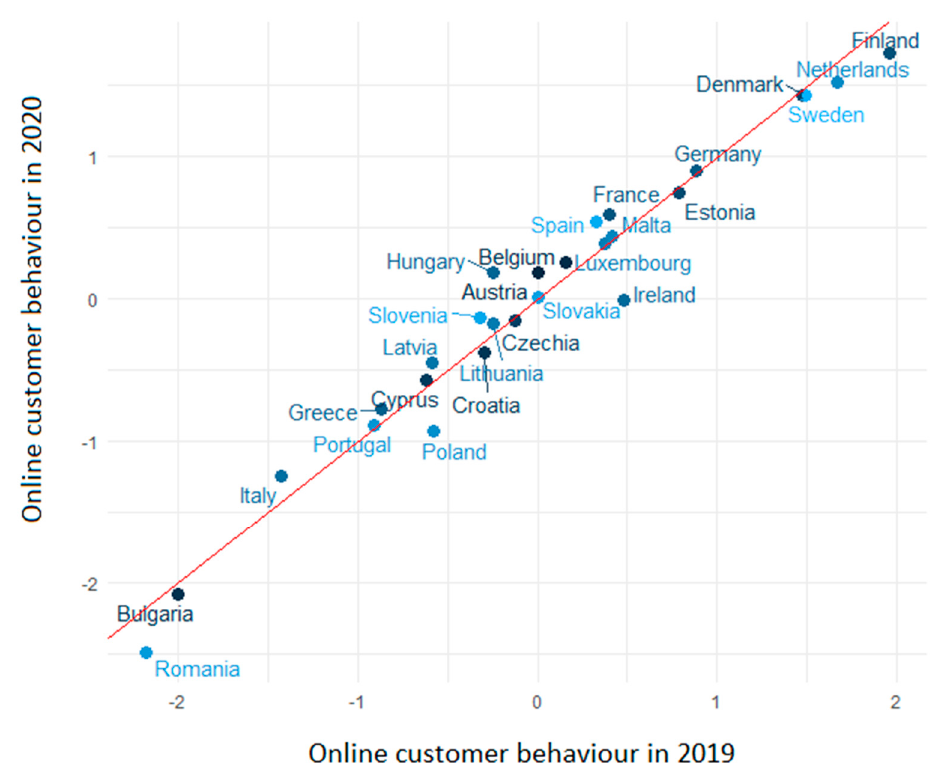
Figure 3. Comparison of EU countries made for the latent variable “online customer behavior”. Source, own study.